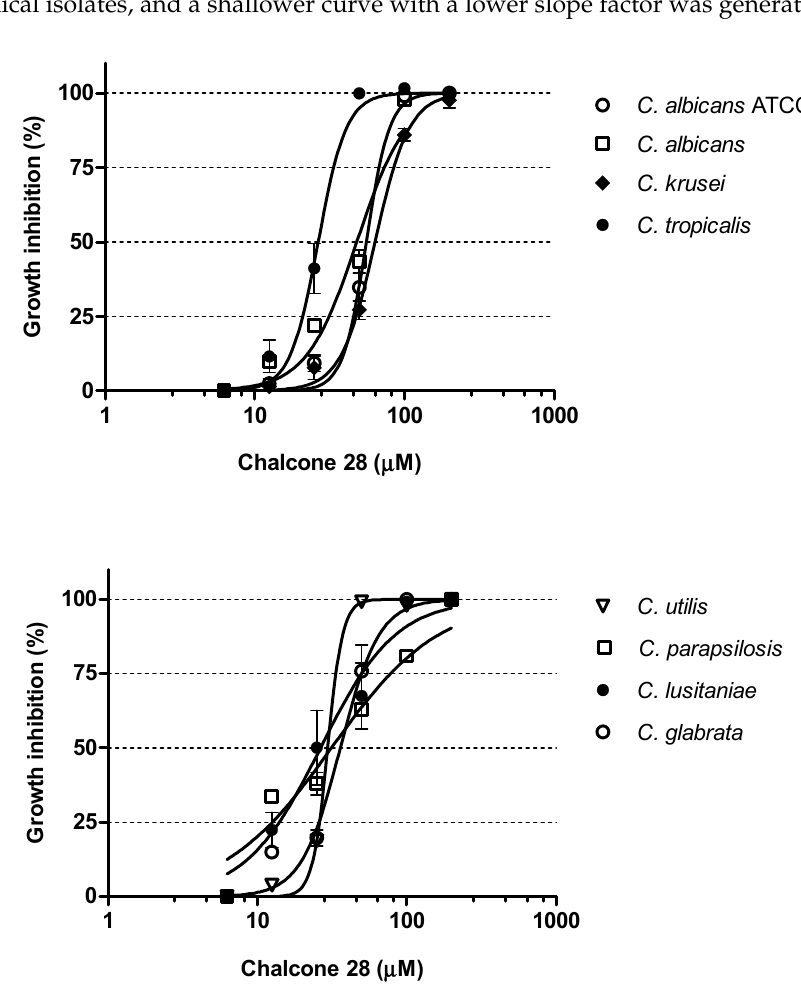
Figure 2. Dose–response curves of chalcone 28 obtained with C. albicans ATCC 10231 and all Candida spp. clinical isolates.